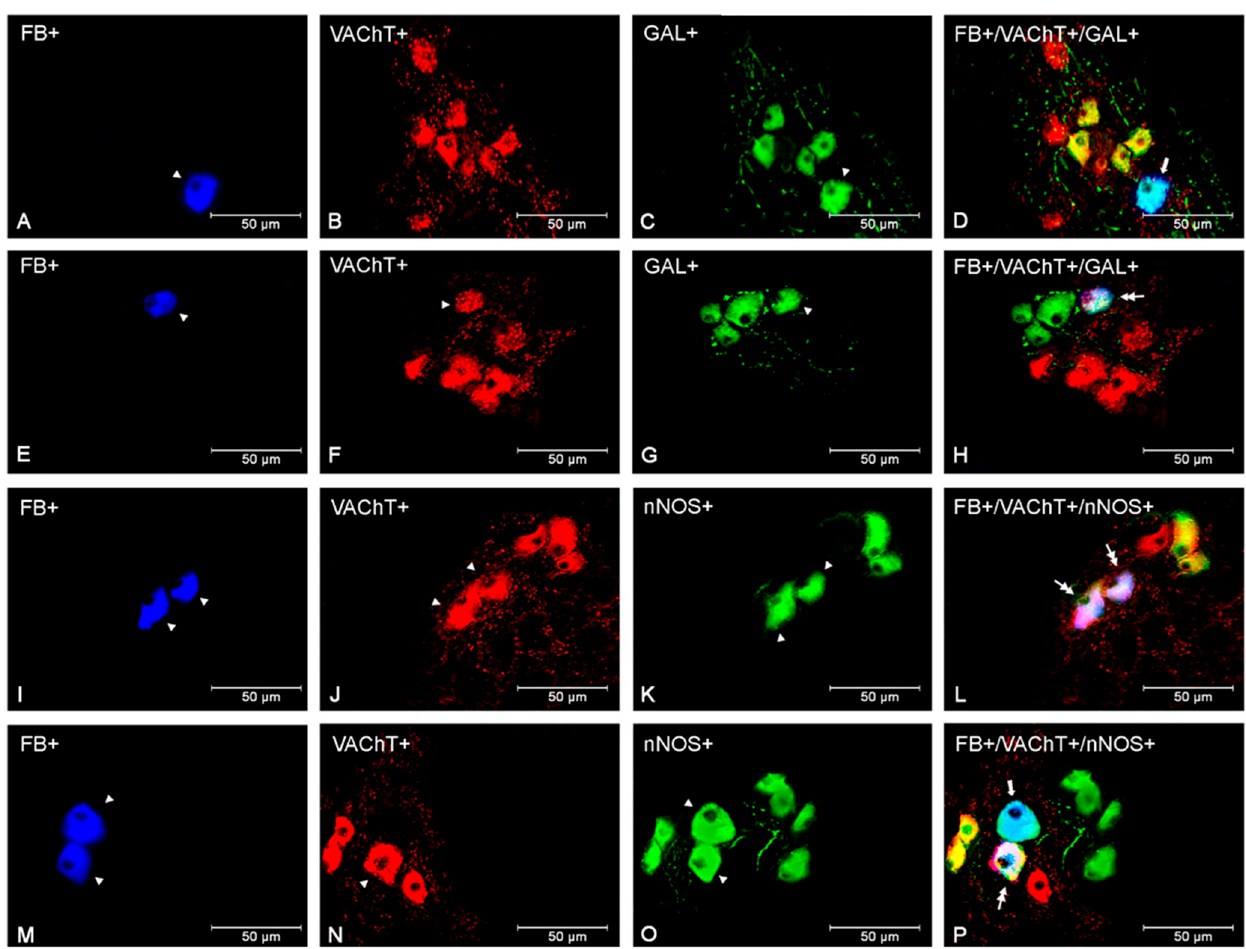
Figure 3. Micrographs demonstrating the presence of VAChT ( B , F , J , N ), GAL ( C , G ), and nNOS ( K , O ) in the PCG uterine perikarya of gilts from the control ( A – D ), saline ( I – L ), and E . coli ( E – H , M – P ) groups. The arrowhead indicates a Fast Blue (FB)-positive neuron, a perikaryon immunoreactive to VAChT, a neuron immunoreactive to GAL, as well as an nNOS-immunoreactive perikaryon. The double arrow indicates an FB-positive uterine neuron expressing VAChT and GAL/nNOS, whereas the arrow shows an FB-positive and GAL/nNOS immunoreactive neuron. The photographs were made using the digital superimposition of three color channels: FB-positive (blue), VAChT-positive (red), and nNOS- or GAL-positive (green). One perikaryon expressing GAL but not VAChT is present in the ganglion of the control group ( A – D ). In the E . coli group, a perikaryon expressing these substances is observed in the PCG ( E – H ). Two VAChT and nNOS immunoreactive uterine neurons are visible in the gilt of the saline group ( I – L ). In the PCG of the E . coli group, a decreased number of perikarya expressing these substances are visible ( M – P ).